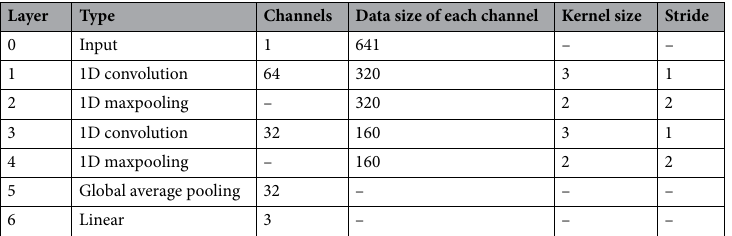
Table 3. Performance of 1D CNN with two convolution layers according to varying number of channels of the second convolution layer from 8 to 128 with the optimized first convolution layer with 64 channels.